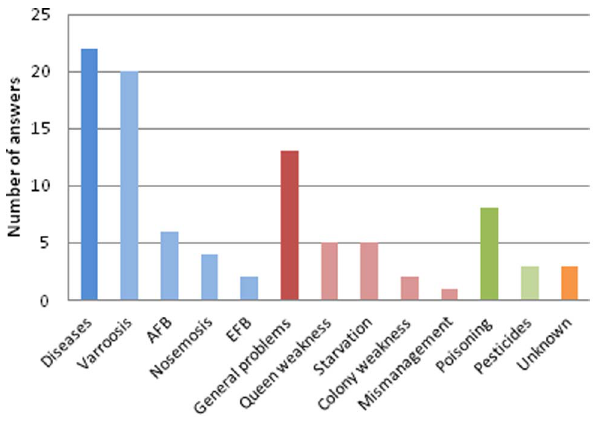
Figure 4. Main causes of colony mortality reported by beekeepers in 2010. Diseases: non-specified diseases, AFB: American foulbrood, EFB: European foulbrood.